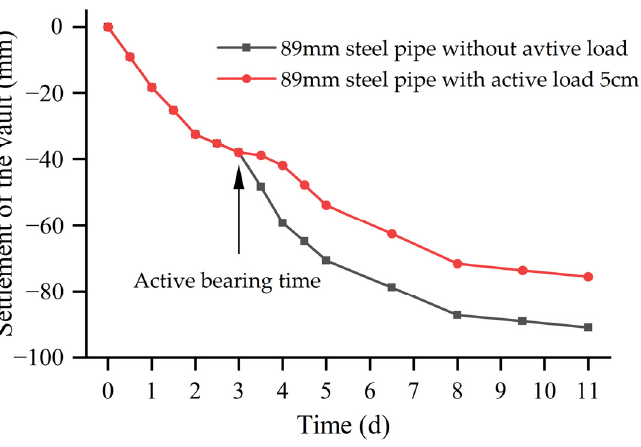
Figure 16. Active bearing effect of 42mm diameter steel pipe.